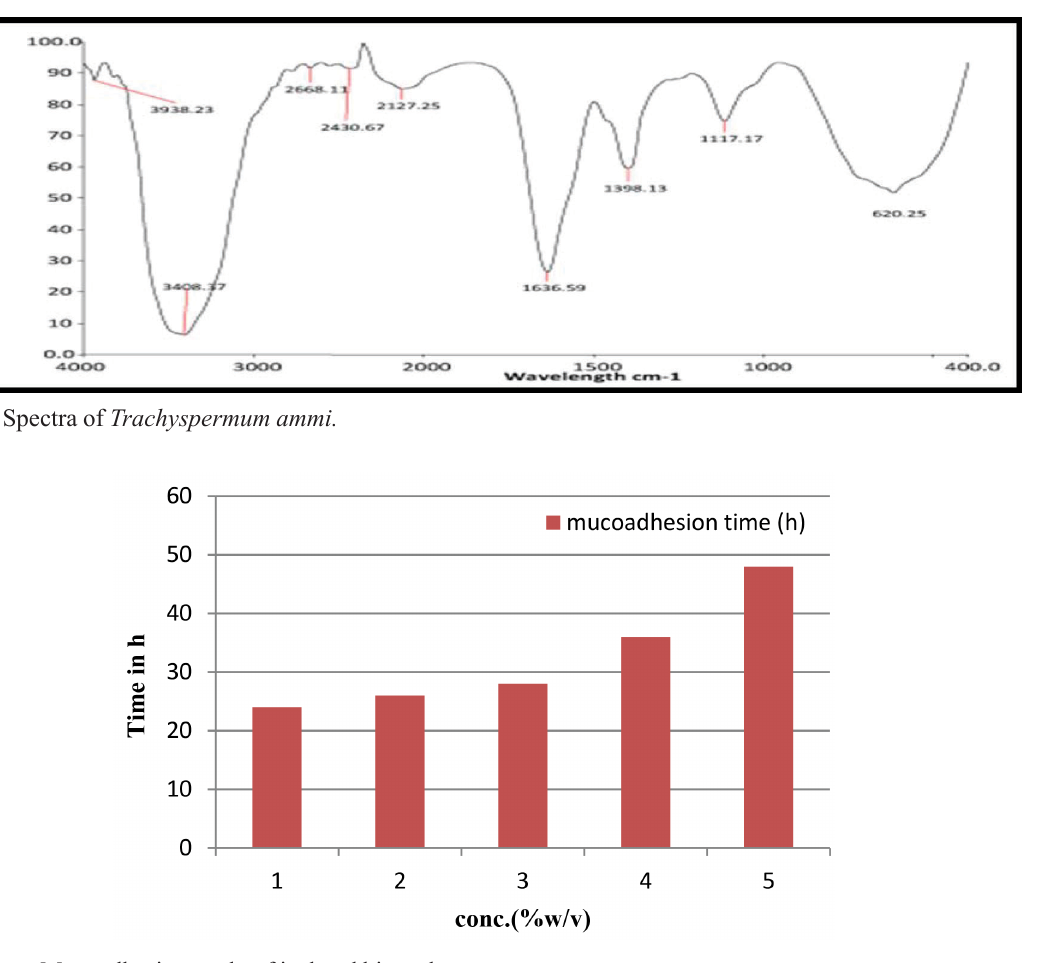
FIGURE 2 - In-vitro Mucoadhesion study of isolated